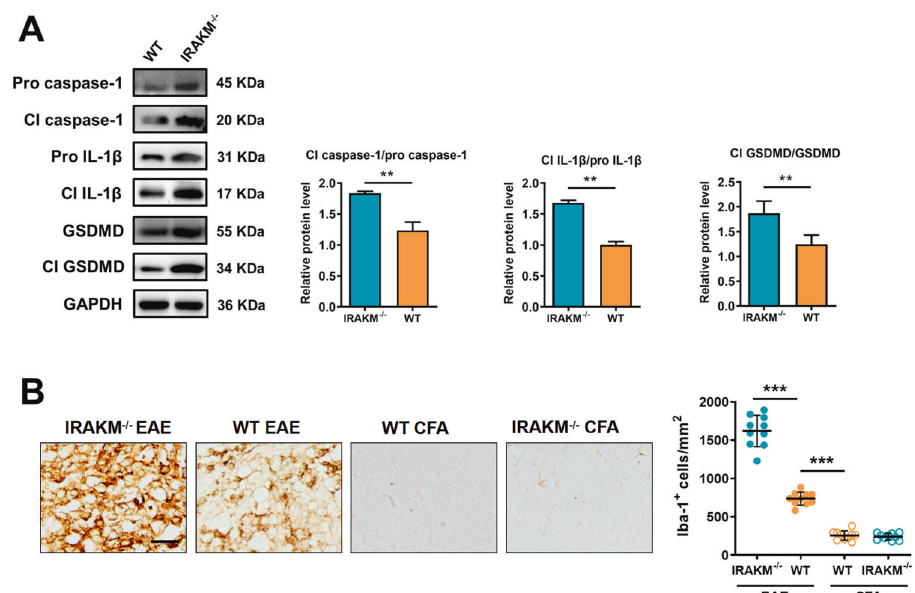
Fig. 4 IRAK-M de fi ciency promotes activation of microglia, NLRP3 in fl ammasomes, and GSDMD-mediated pyroptosis in the microglia of EAE. A Western blotting of full-length (FL) and cleaved caspase-1, IL-1 β , and GSDMD. The corresponding charts show the quanti fi cation of target protein expression ( n = 4 per group). B Immunohistochemistry for the detection of Iba-1 + microglia in fi ltrated in the lumbosacral spinal cord at peak disease. The left panel shows representative images. Scale bar: 50 μ m. The right panel shows the quanti fi cation of cell numbers, respectively. Three sections per mouse were evaluated ( n = 4 per group). Data were analyzed by an unpaired t -test or the Mann – Whitney U test and are shown as the mean ± SEM. ** P < 0.01, *** P <